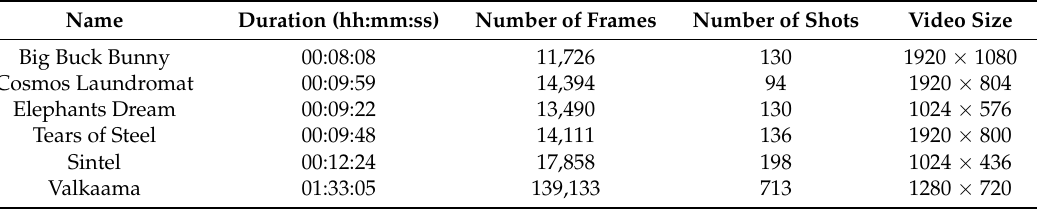
Table 9. Annotations of the OVSD dataset.